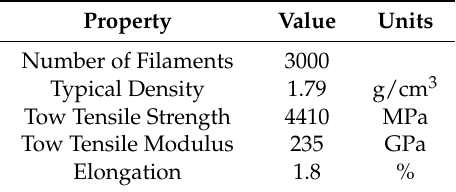
Table 3. As supplied typical fibre properties.